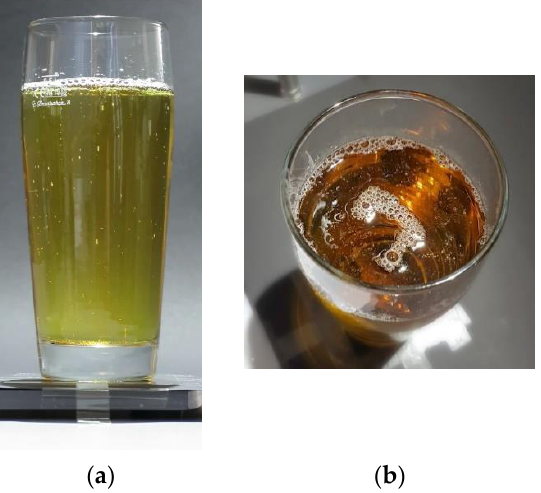
Figure 8. Sample s06 after 40 s. ( a ) Foam is detected by automated image analysis of RGB image, even though this is just foam clinging to the beer glass; ( b ) 3D camera records this as lack of foam.